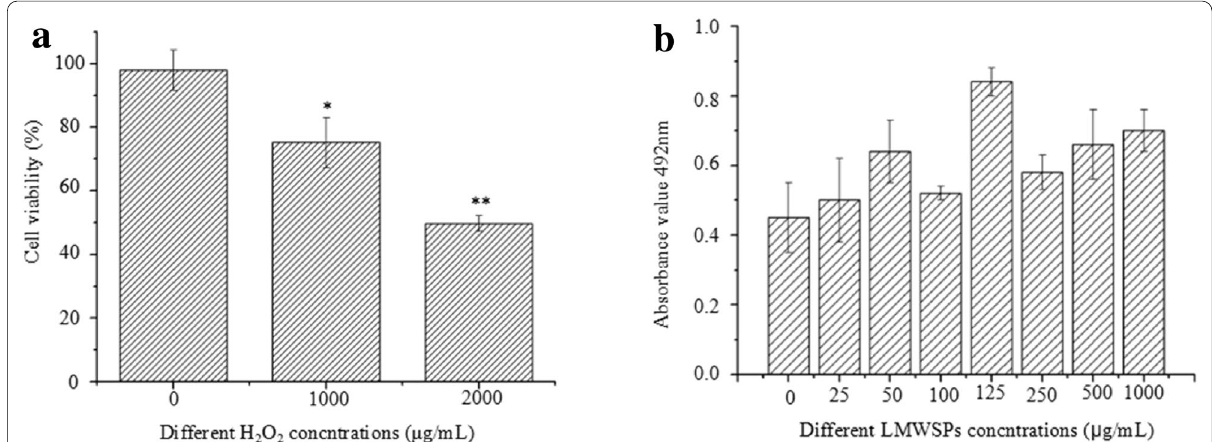
Fig. 2 a Viability of L02 cell pretreatment with H 2 O 2 and LMWSPs by the MTT assay. Cells were incubated with the indicated concentrations of H 2 O 2 for 24 h, and the effects of H 2 O 2 on the L02 cells were analyzed. b Effects of LMWSPs in different concentrations (0–1000 μg/mL) on the L02 cells. The bar graph represents mean